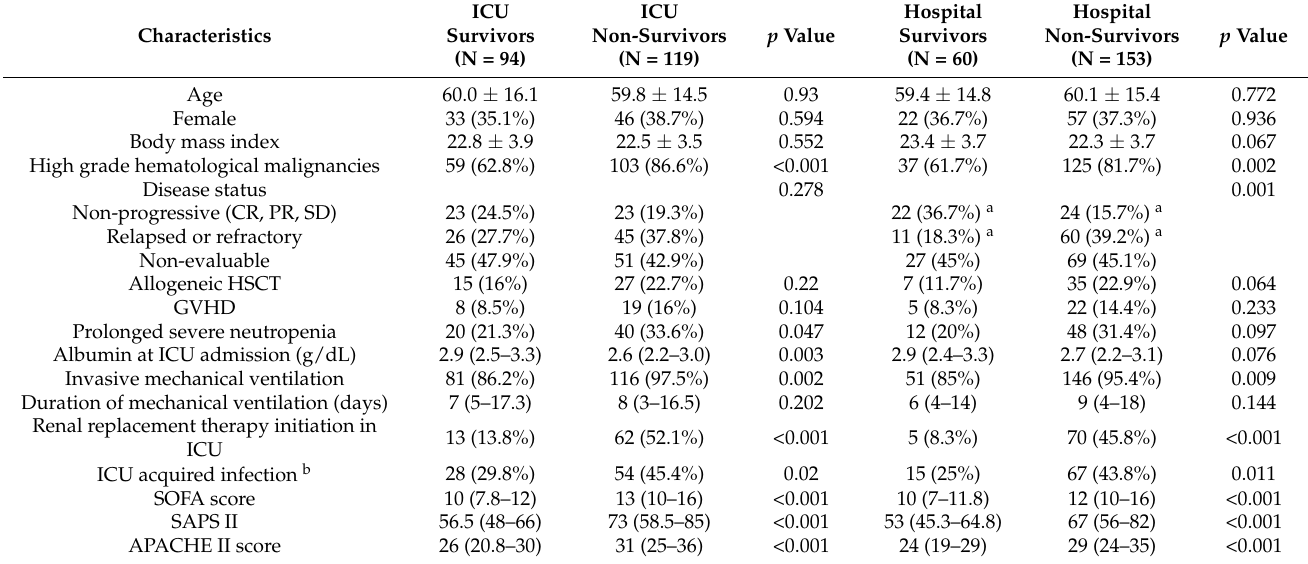
Table 2. Comparisons between survivors and non-survivors with hematological malignancies.